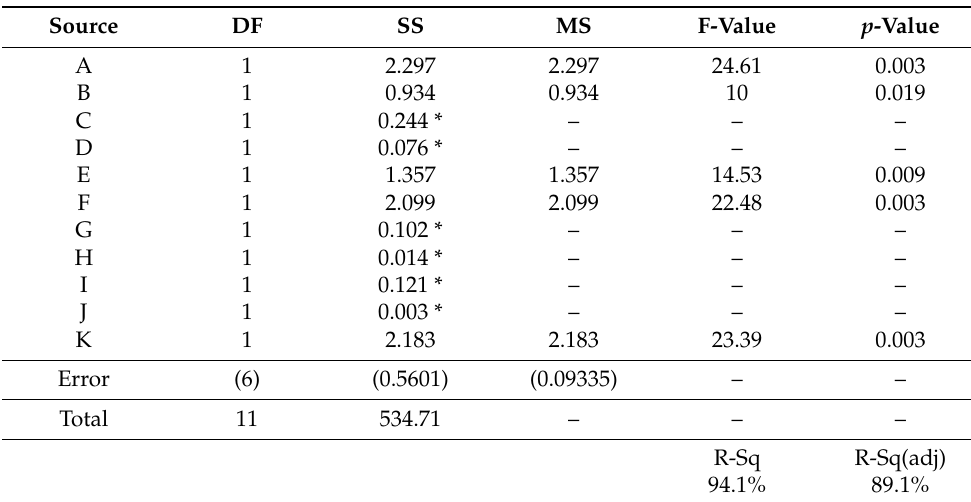
Figure 11. The response graph for the S/N ratios of the L 12 (2 11 ) experiment. Table 5. ANOVA on the S/N ratios of the L 12 (2 11 ) experiment.